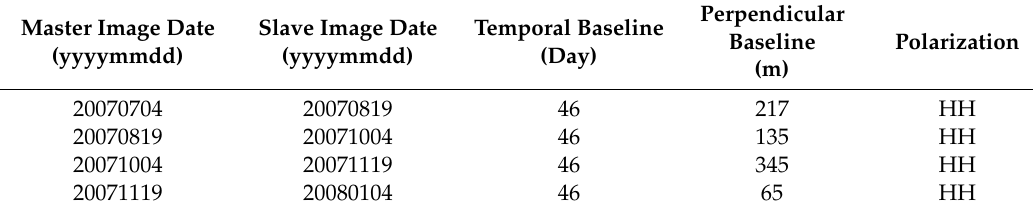
Table 1. Basic parameters of the Advanced Land Observing Satellite (ALOS) / Phased Array type L-band Synthetic Aperture Radar (PALSAR) images.